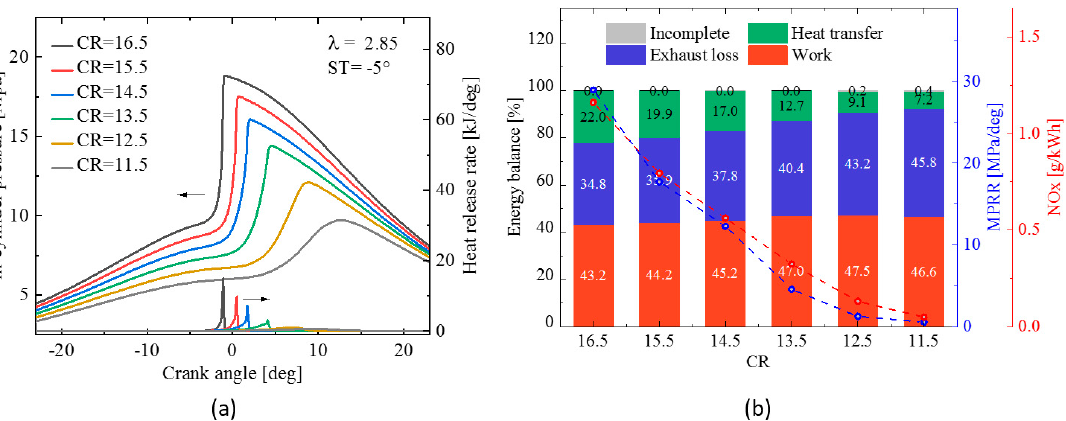
Figure 7. Comparison of: ( a ) pressure trace and heat release rate traces; and ( b ) efficiency for λ = 2.85 and ST = − 5 CAD at different